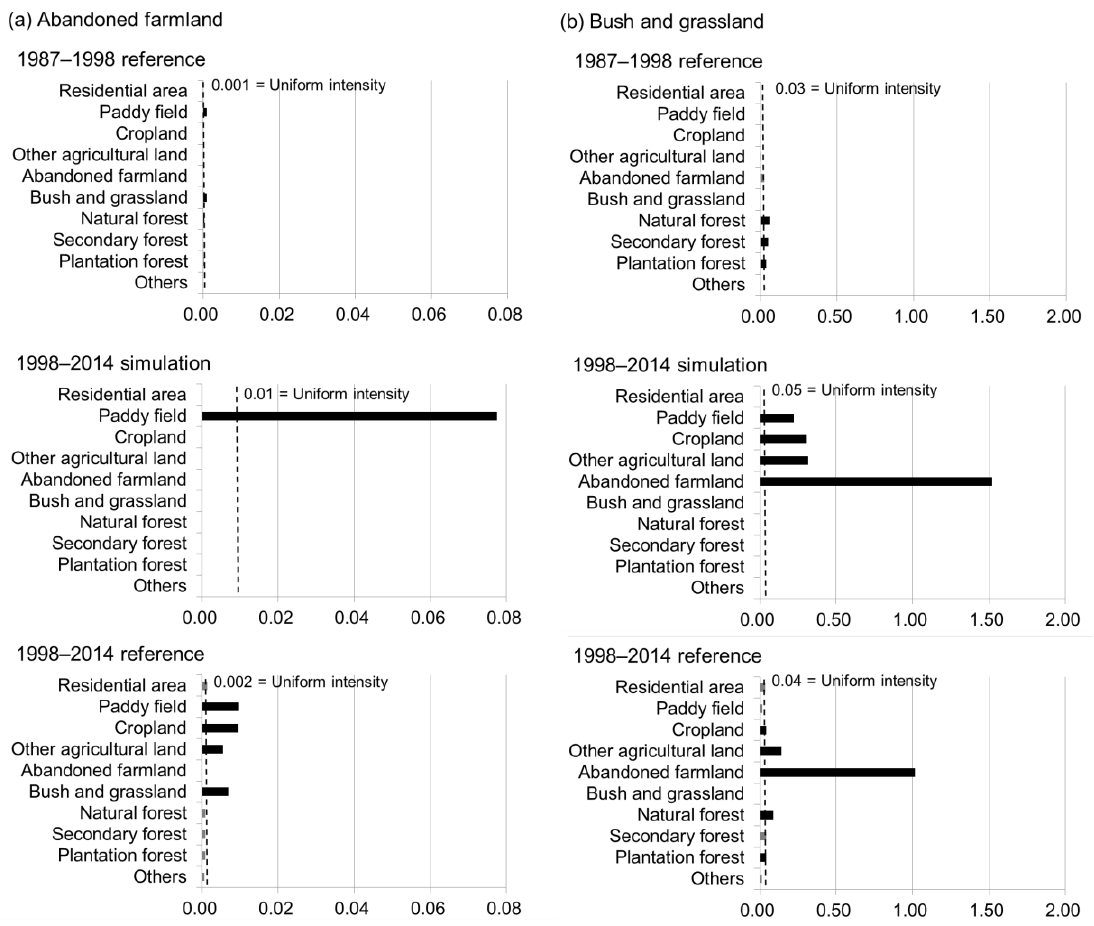
Figure 3. Transition intensities for the gains of ( a ) abandoned farmland and ( b ) bush and grassland for the 1987 – 1998 reference (calibration), 1998 – 2014 simulation, and 1998 – 2014 reference (validation) intervals. Black bars show active transitions and grey bars show dormant transitions. The vertical dashed line shows uniform intensity.